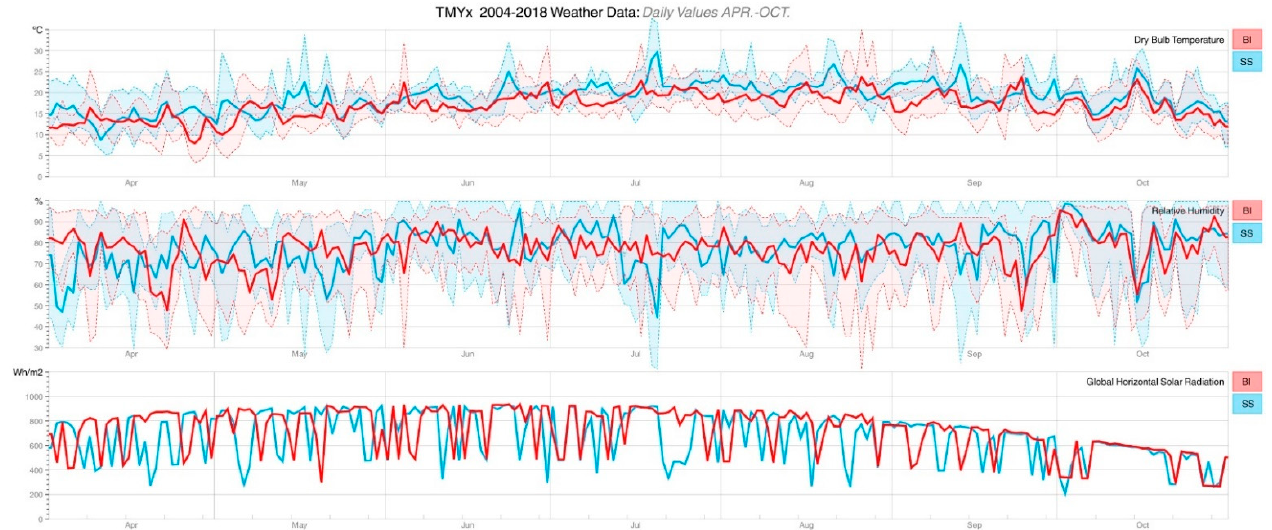
Figure 11. TMYx statistical weather data (2004–2018) for Bilbao (red) and San Sebastian (blue), April to October. Source: authors.